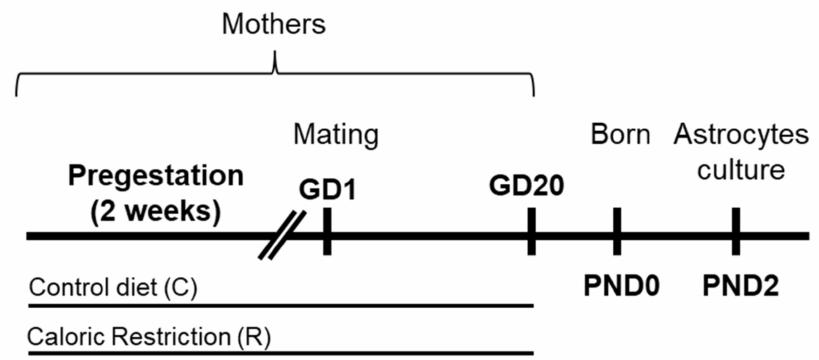
Figure 7. Experimental design. Female rats (dams) were exposed to a control diet (C) or caloric restriction diet (R) during pregestation (2 weeks before mating) and gestation (20 days